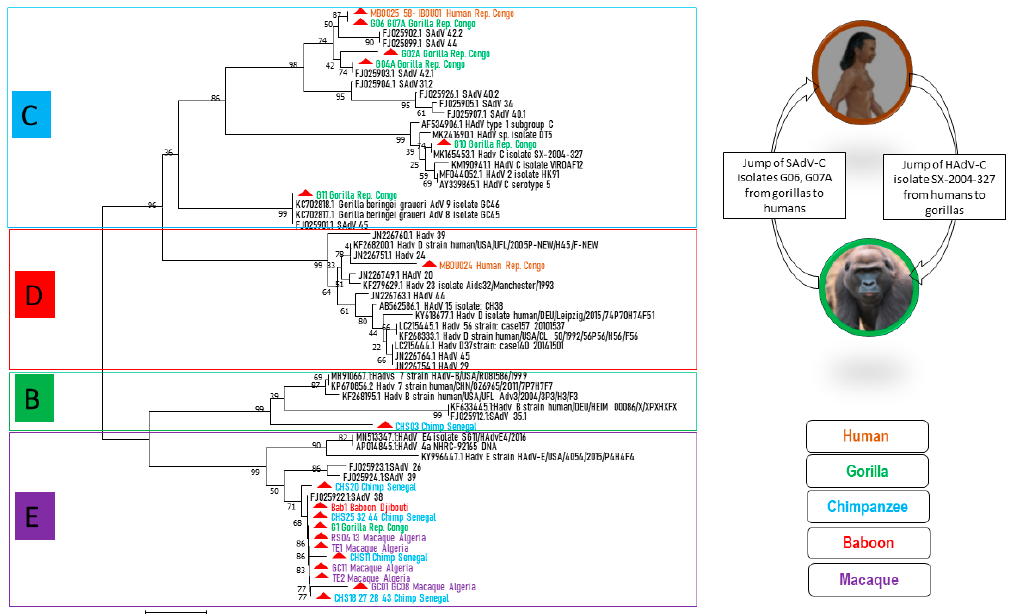
Figure 2. Molecular phylogenetic analysis by maximum likelihood method based on a short (250 bps) sequence alignment of the DNA polymerase gene of human and simian adenoviruses. The evolutionary history was inferred using the maximum likelihood method, based on the Tamura three-parameter model. Sequences were aligned by the ClustalW method and compared with each other as well as with available DNA polymerase sequences from GenBank. Sequences in this study are indicated by the following colors: brown for humans; green for gorillas; blue for chimpanzees; violet for macaques and red for baboons. Sequences from GenBank are in black . AdV types from HAdV-C, -B and -E were detected in African NHPs and from HAdV-C and -D in humans. HAdV-C jumped from humans to gorillas and, inversely, HAdV-C strains G06 and G07A jumped from gorillas to humans from the Republic of Congo. The tree with the highest log likelihood ( − 1102.33) is shown. The percentage of trees in which the associated taxa clustered together is shown next to the branches. The tree is drawn to scale, with branch lengths measured in the number of substitutions per site. The analysis involved 59 nucleotide sequences. The confidence probability (multiplied by 100) for the inside length of the branch is greater than 0, as estimated by the bootstrap test (1000), which is shown next to the branches. In the Republic of Congo, we found HAdV-C and E members in gorillas and HAdV-C and D members in humans, with an abundance of C members in both humans and gorillas (Table S1). In Senegal, HAdV-B and E members were detected in chimpanzees, and the E members were the most prevalent ones. AdV-E was also found in baboons from Djibouti. In Algeria, the macaques were infected by AdV-E types. In this study, the green monkeys were negative for AdVs, probably due to the limited number of samples (only four samples).